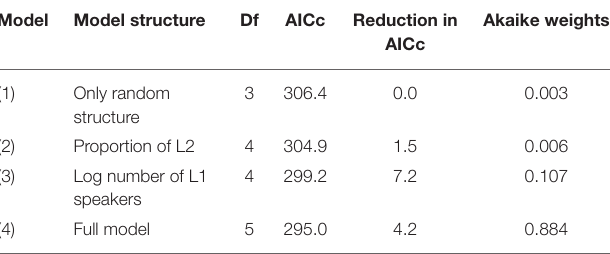
TABLE 4 | Results of model comparison for the reduced model SYNTHESIS.ALL. The full model includes both the log number of L1 speakers and the proportion of L2